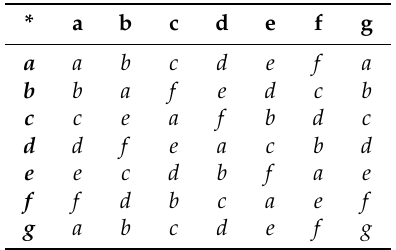
Table 7. Non-commutative perfect